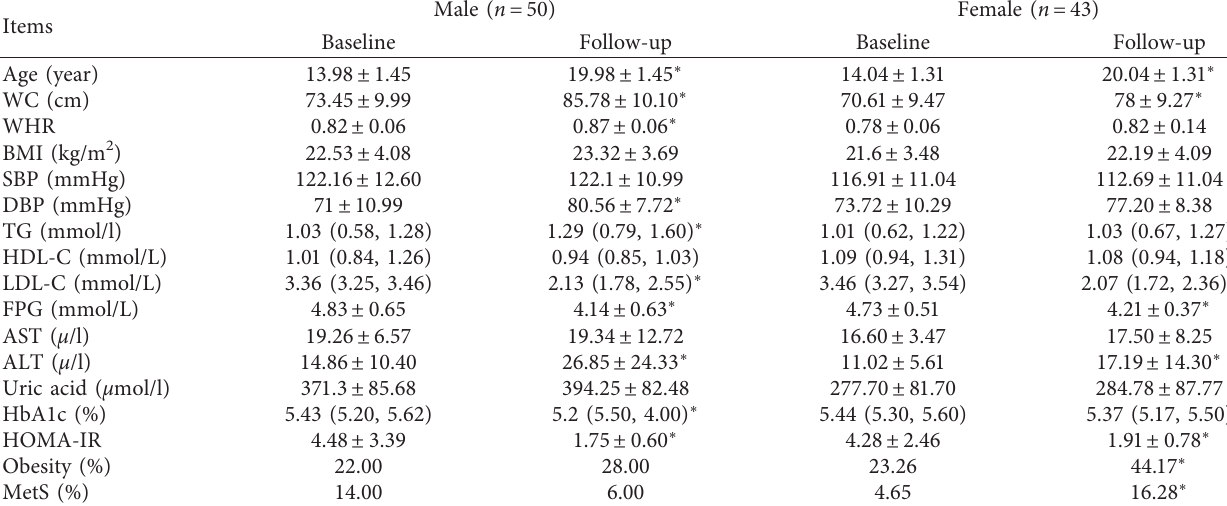
Table 1: Baseline and follow-up clinical characteristics of subjects.